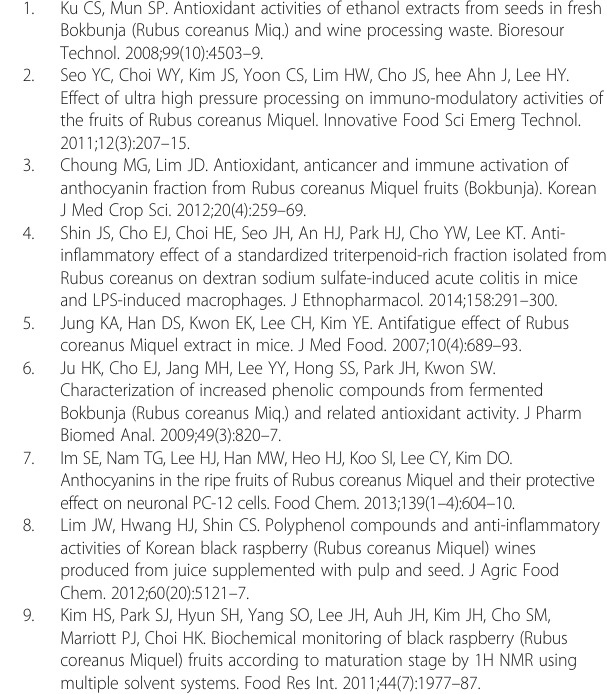
Additional file 1: Figure S1. Anti-inflammatory effect of extracts from Rubus coreanus fruit (RF) on RAW264.7 protein expression. Cells were pretreated with 200 μ g/mL mature RF (MRF) and immature RF (IRF) for 1 h and then induced with 1 μ g/mL LPS for 18h. Cells were lysed and proteins were employed by SDS-PAGE followed by Western blotting using primary antibodies targeting anti-p-p65, p-ikB-a, COX-2, iNOS and β -actin. (DOCX 414